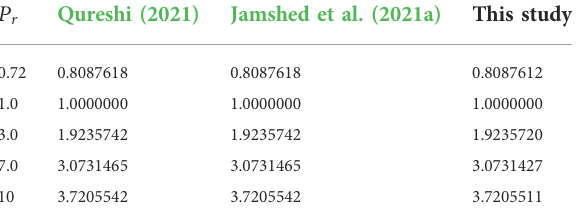
TABLE 4 Comparing − θ 9 ( 0 ) with alteration in Prandtl number, and taking β * (cid:2) Ec (cid:2) M (cid:2) 0 and B i (cid:2) 0. P r